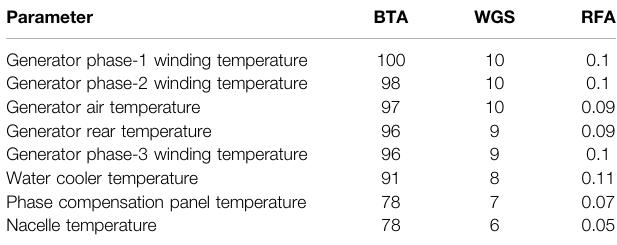
TABLE 2 | Dataset